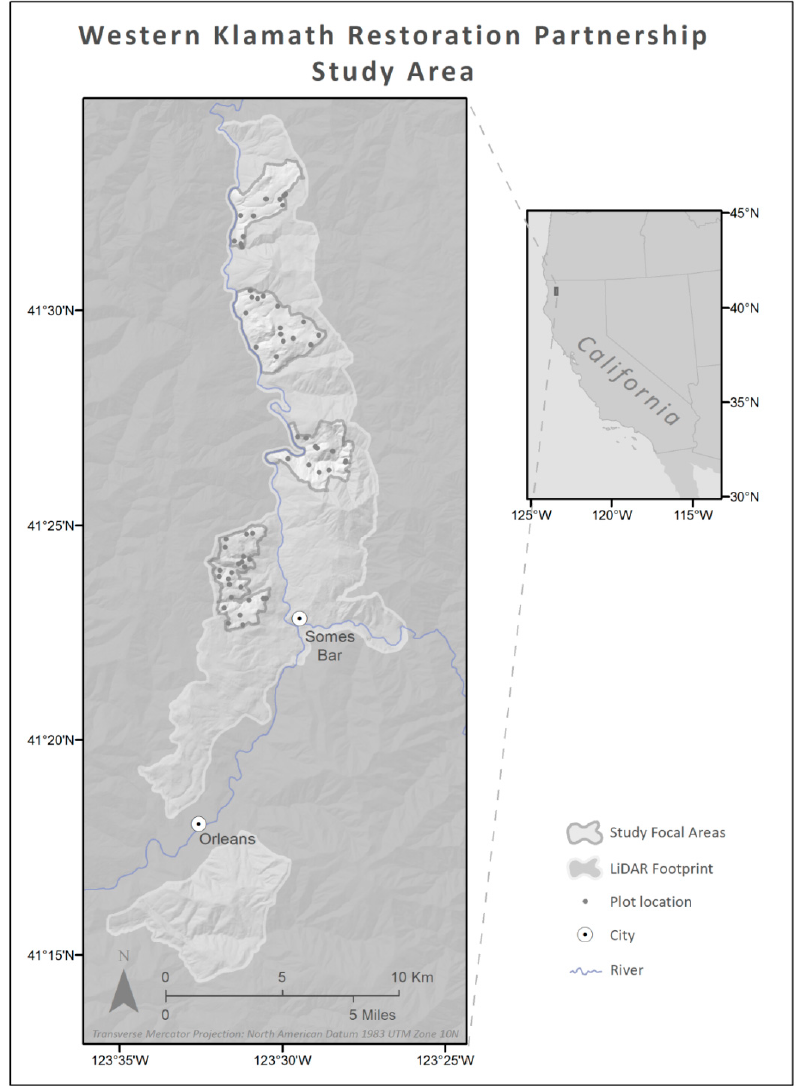
Figure 1. Klamath River study area between Orleans and Happy Camp, CA. Within the 14,323 ha